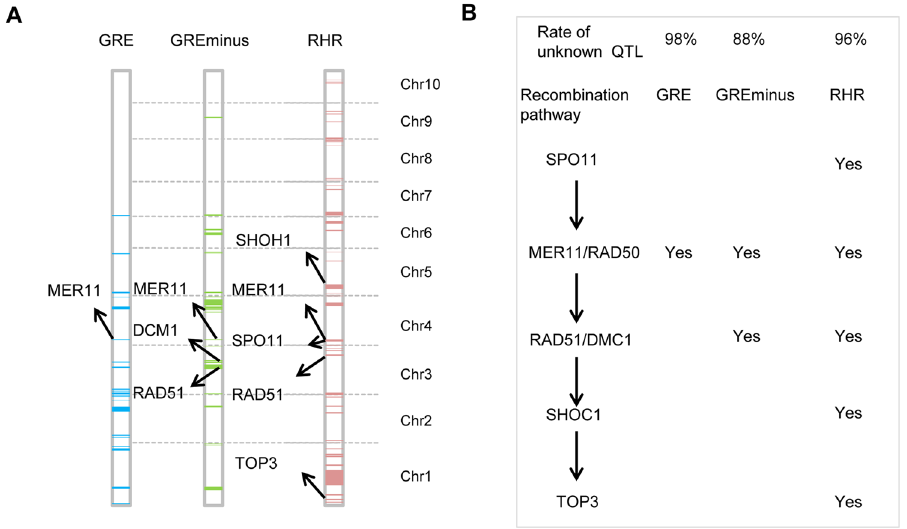
Figure 2. Relationships between recombination QTLs and recombination patyway genes. ( A ) Co-localization of recombination pathway genes with recombination QTLs for GRE, GREminus and RHR. ( B ) Scenario of recombination pathway genes that were detected by the QTL mapping for GRE, GREminus and